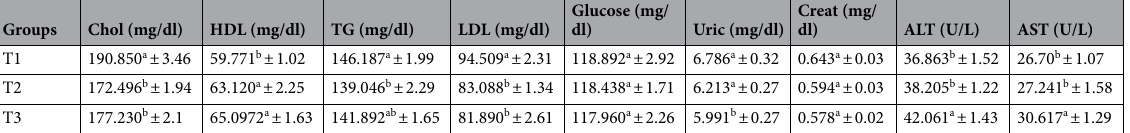
Table 4. Effects of ZnONPs supplementation on serum biochemical parameters of broiler chicks. Values are means ± SEM. a, b—Means in the same column with different superscripts are significantly different ( P < 0.05).